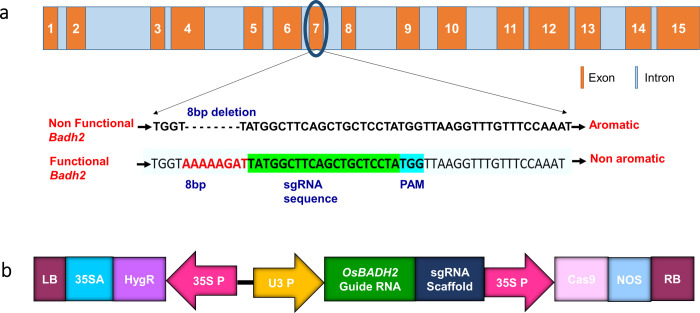
Details of the target gene and vector used.a) Structure of OsBADH2 and target region on 7th exon chosen for designing sgRNA; b) Schematic representation of CRISPR/Cas9 vector pRGEB31 with sgRNA targeting OsBADH2 used for stable Agrobacterium-mediated transformation of rice.